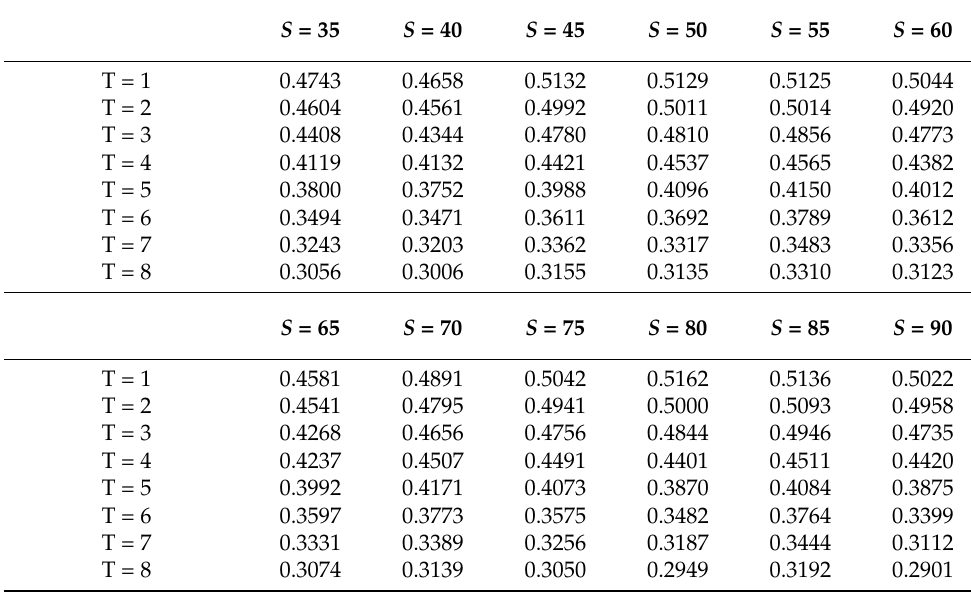
Table A15. The IoU of SVM varies with sampling size S and threshold level